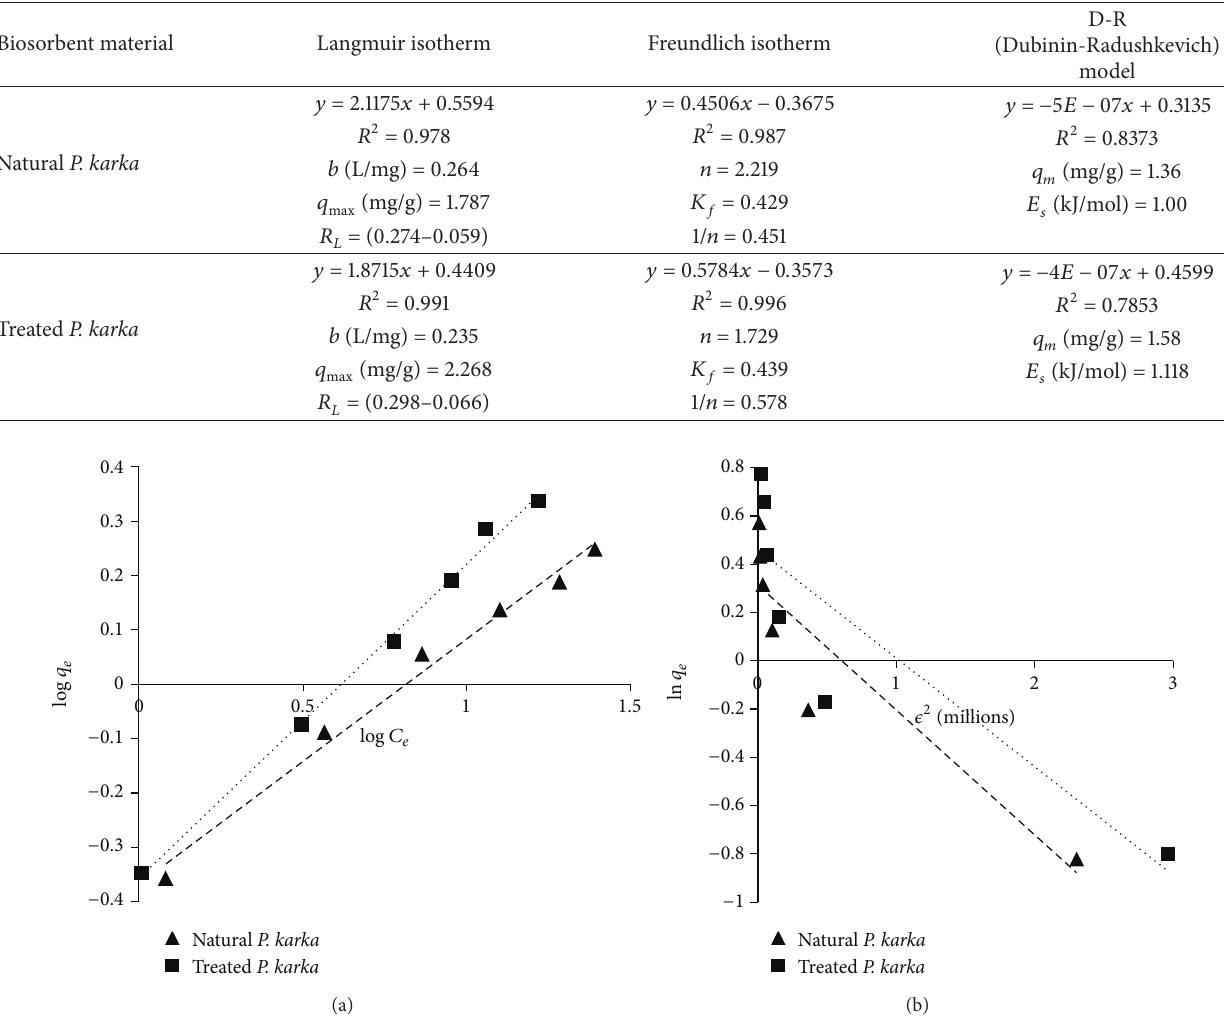
Table 2: Langmuir isotherm, Freundlich isotherm, and D-R model parameters for the biosorption of mercury ions on the surface of natural P. karka and treated P. karka .